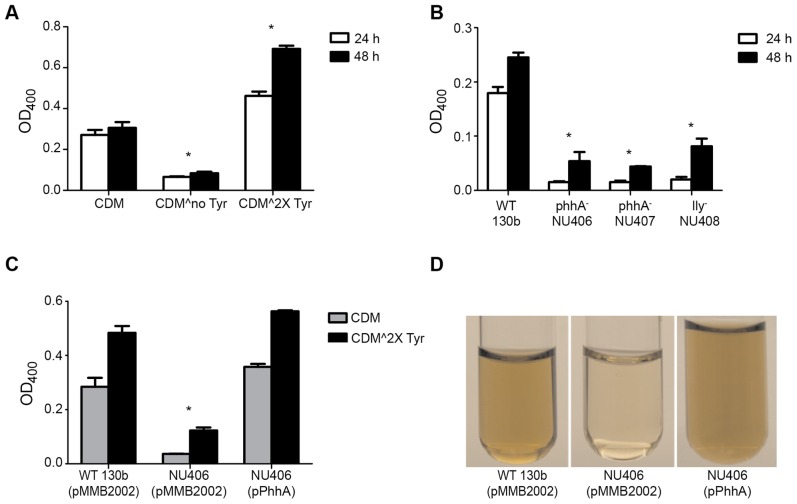
Pigmentation of wild-type and phhA mutant L. pneumophila.(A) Wild-type (WT) L. pneumophila 130b was inoculated into either standard CDM, CDM lacking tyrosine (CDMˆno Tyr), or CDM containing twice the normal amount of tyrosine (CDMˆ2X Tyr), and then at 24 and 48 h post-inoculation the levels of pigment in the cultures were determined by measuring the OD400 of the cultures supernatants. (B) L. pneumophila 130b WT, phhA mutants NU406 and NU407, and lly mutant NU408 were inoculated into standard CDM containing tyrosine, and then at 24 and 48 h, the amount of pigment produced was determined by assessing the OD400 of culture supernatants. (C) WT and mutant NU406 carrying the vector pMMB2002 and NU406 carrying the phhA gene cloned into pMMB2002 (i.e., pPhhA) were cultured in either standard CDM containing tyrosine (gray bars) or CDM containing twice the normal amount of tyrosine (black bars), and then at 24 h post-inoculation the OD400 of the cultures were determined. (D) Photographs of cell-free supernatants from 24-h CDM cultures (with the standard amount of tyrosine) of WT and phhA mutant strain NU406 carrying vector and NU406 carrying the cloned phhA. In panels (A – C), the asterisks indicate a P value of <0.05 compared to the WT control (Student’s t-test). All experiments are representative of three independent trials.